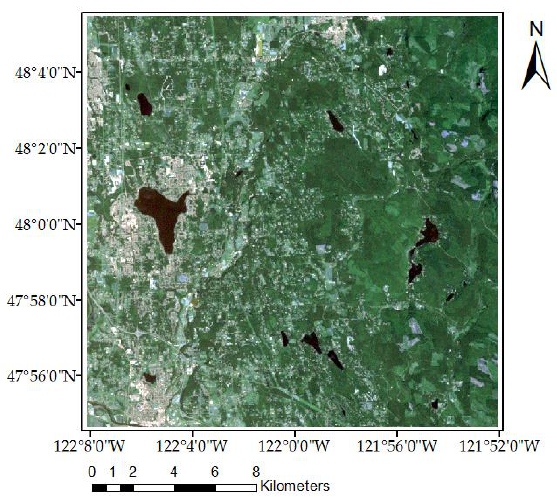
Figure 5. Landsat-7 ETM+ image of 2000. Two patches with 150*150 pixel size were chosen for evaluation.